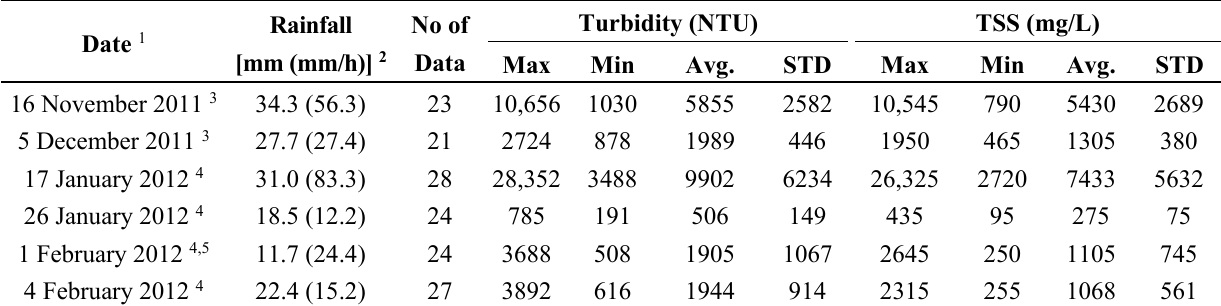
Table 1. Statistical summary of turbidity and total suspended solids (TSS) of inflow stormwater